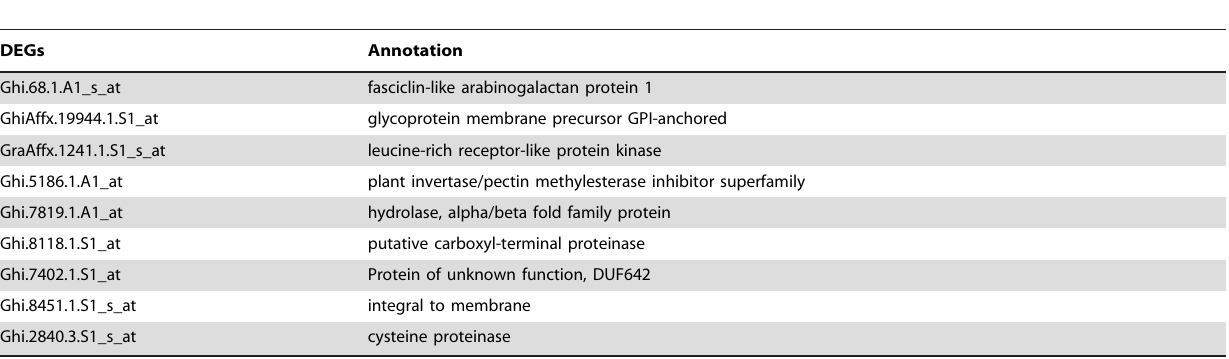
Table 2. Common DEGs involved in vesicle (GO:0031982) in both Li 1 and Li 2 mutants regardless of growth conditions (P value, 1.7e-11; FDR, 3.1e-10).